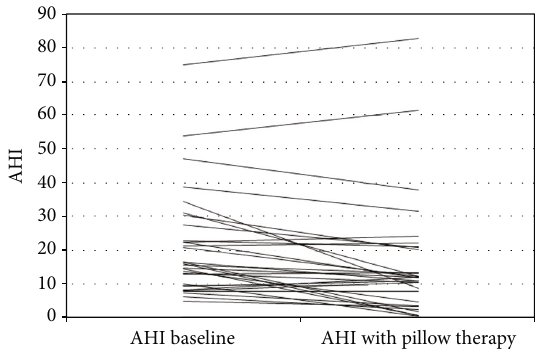
Figure 2: The individual e ff ect of SAP therapy on the apnea- hypopnea index in 30 patients with obstructive sleep